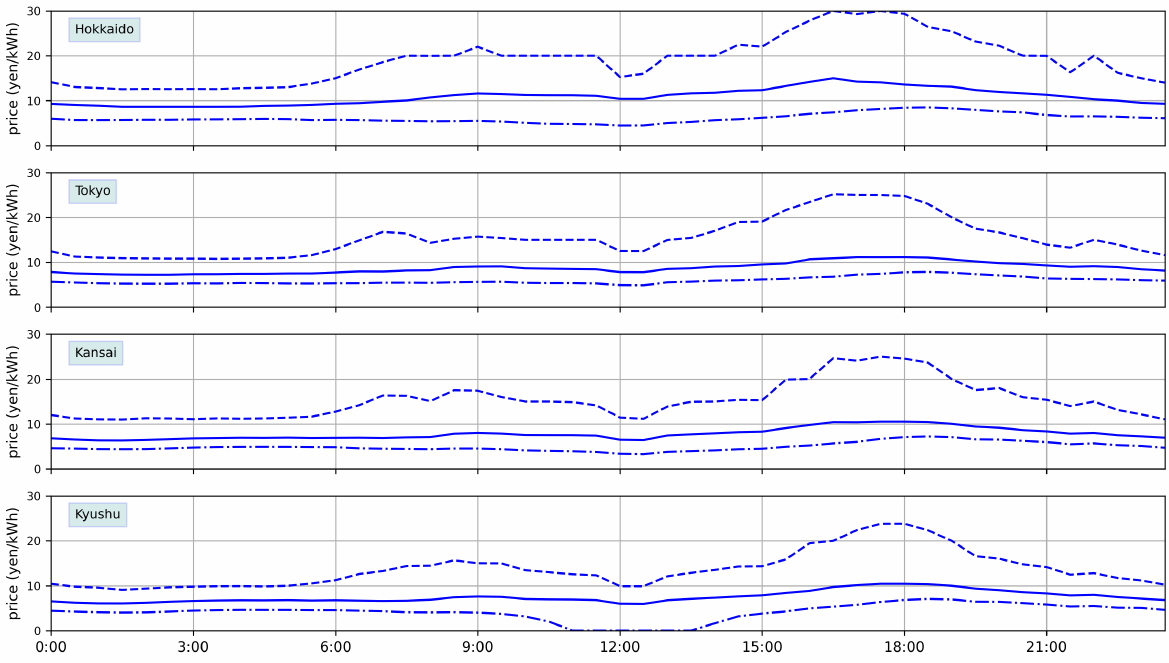
Figure 5. The 10th percentile (dot-dashed line), median (full line) and the 90th percentile (dashed line) for the JEPX area prices time